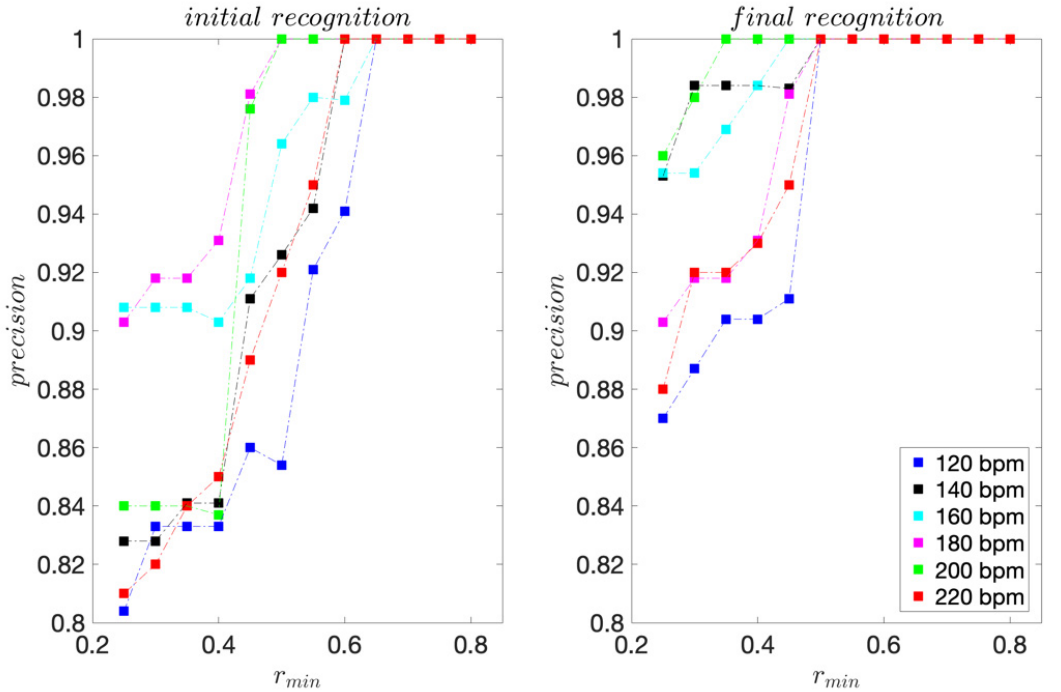
Figure 4. Precision scores obtained for the professional dancer’s test sequences. For the initial template matching, the highest sensitivity scores range from 0.80 to 0.91 and are obtained for r min ≤ 0.4. For the final template matching, they range from 0.84 to 0.96 and are also obtained for r min ≤